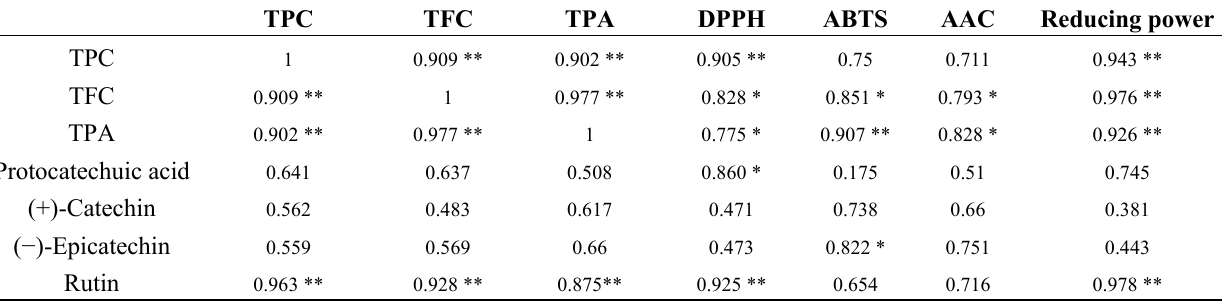
Table 3. Correlation analysis among TPC, TFC, TPA, antioxidant activity and phenolic compounds.